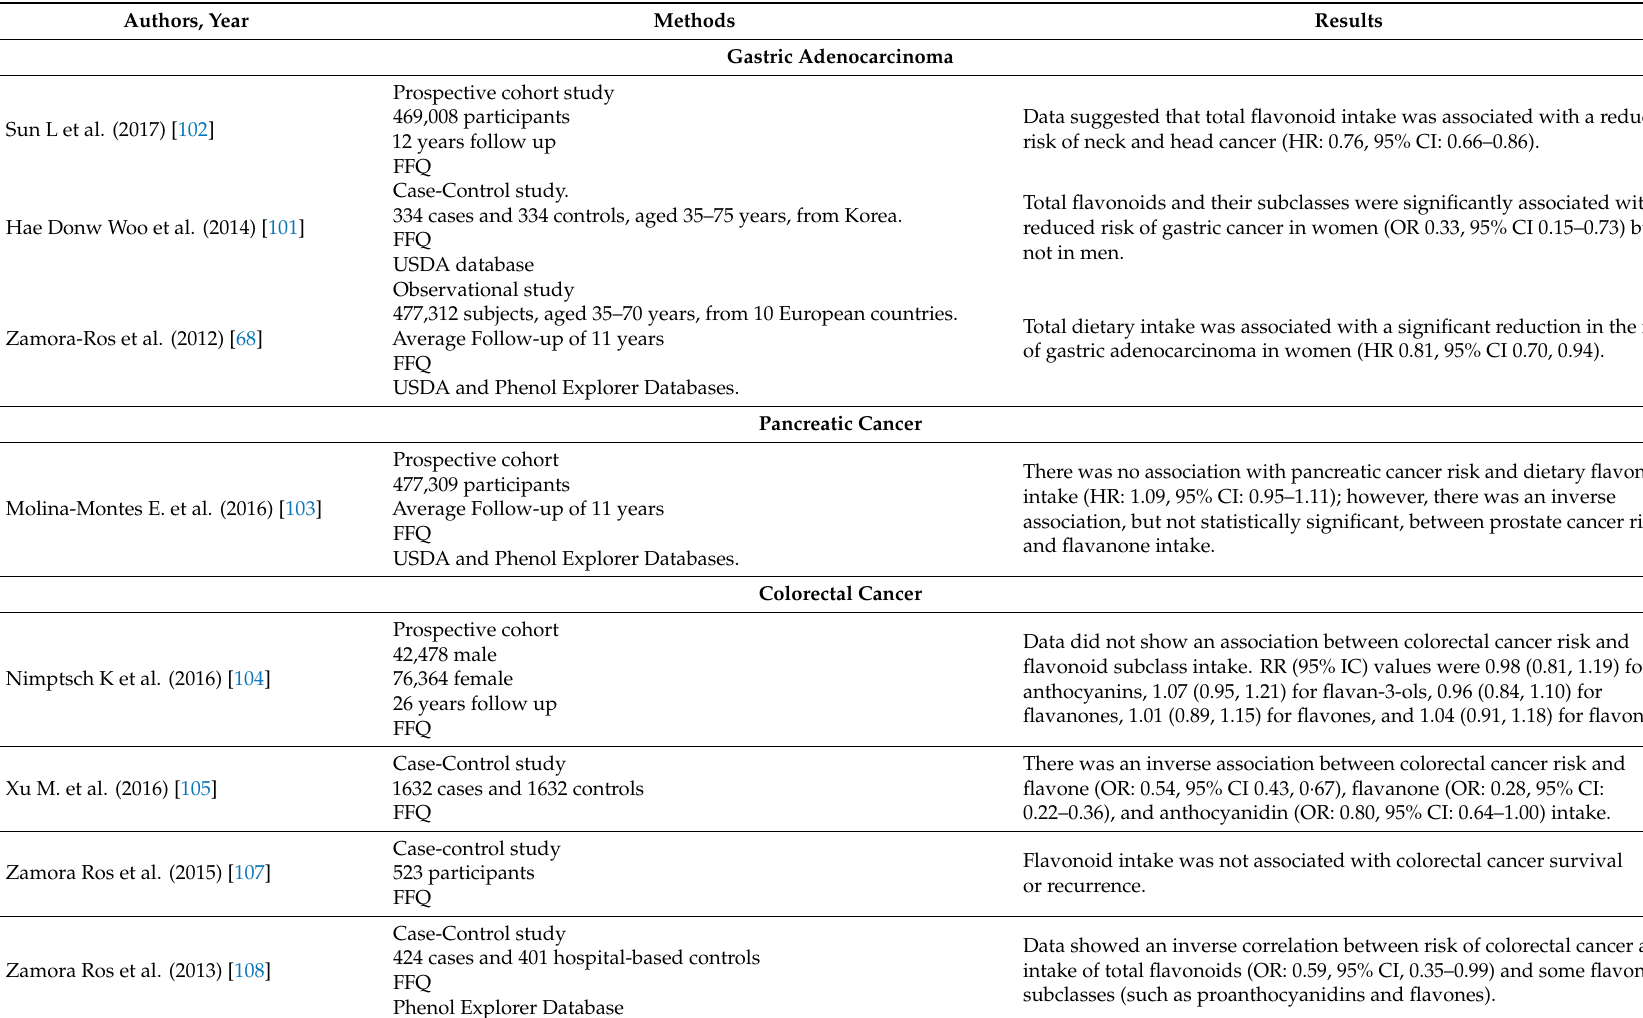
Table 11. Association between flavonoid intake and risk of gastric, pancreatic, and colorectal